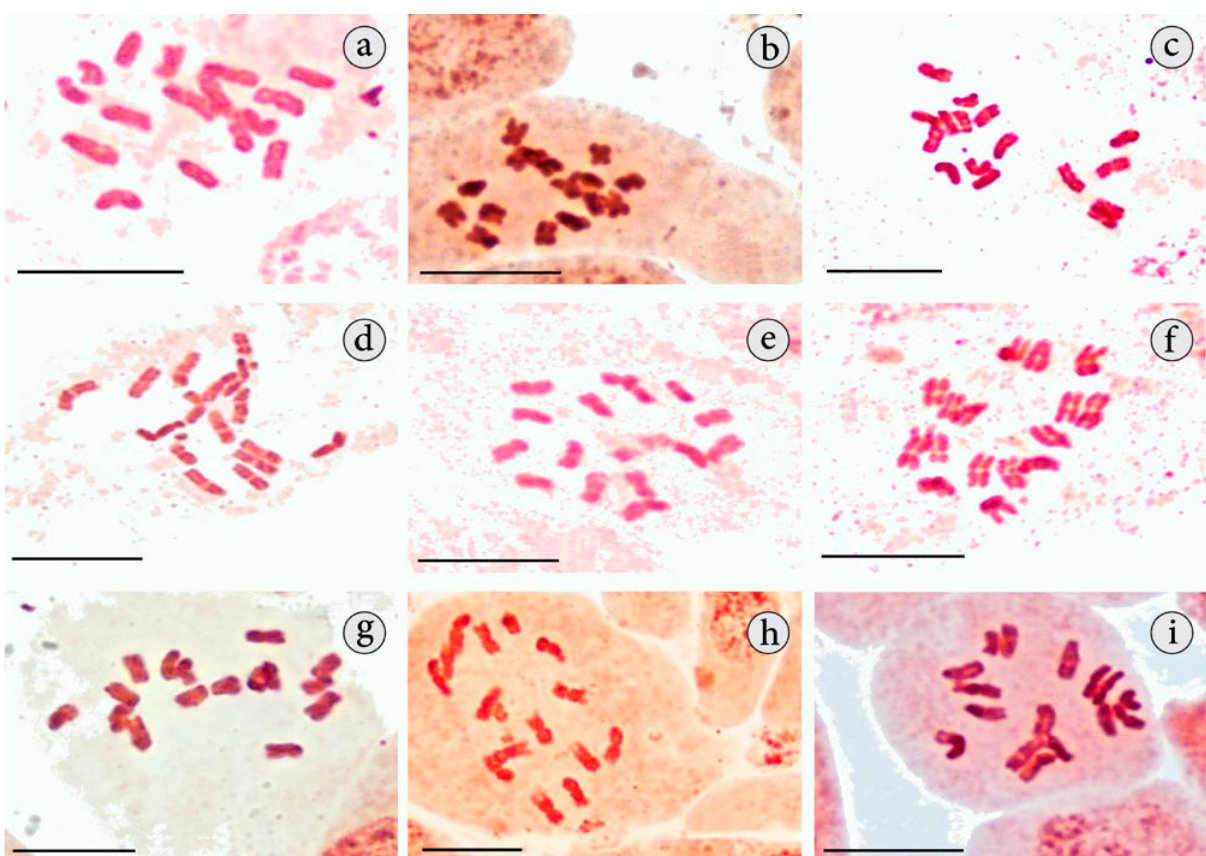
Figure 1. Photographs of somatic metaphase chromosomes of nine populations belonging to six species of the genus Trigonella collected from northeast of Iran. (a, b) T. binaloudensis from two locality; (c) T. heratensis ; (d) T. lasiocarpa ; (e) T. stipitata; (f, g, h) T. subenervis from three locality; (i) T. torbatejamensis . Scale bars = 10